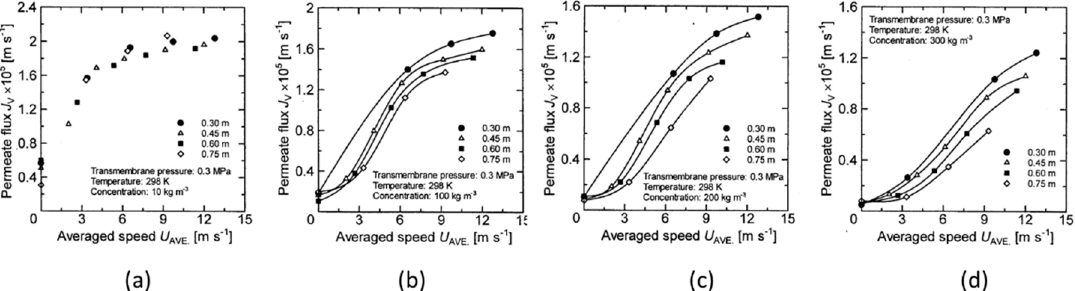
Figure 12. Relationship between average speed and permeate flux when the TMP is 0.2 Mpa. ( a ) at